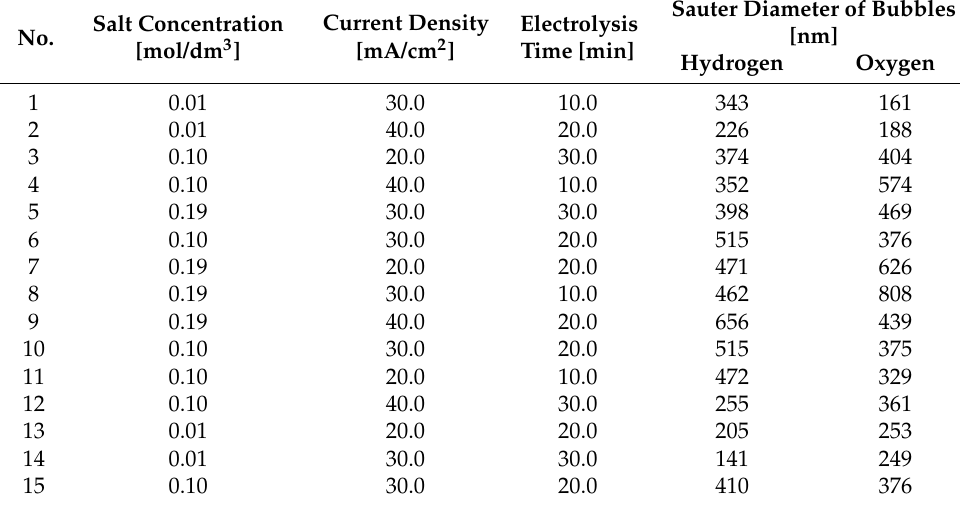
Table 2. Values of Sauter diameter of hydrogen and oxygen bubbles in all experiments rounded to the nearest